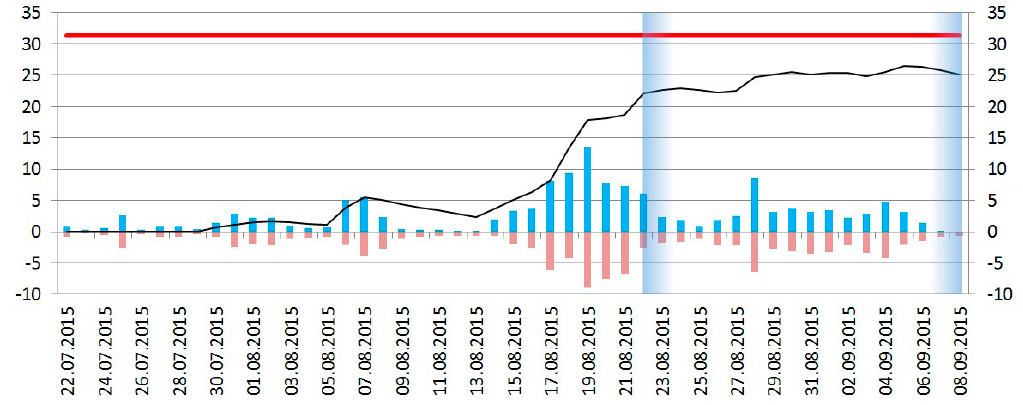
Figure 5. Water balance of the Assam flood: light blue bars represent precipitation values, pink bars—combined evaporation and permeation values, thin black line—accumulated water mass, thick red line—fixed maximum of observed water mass.